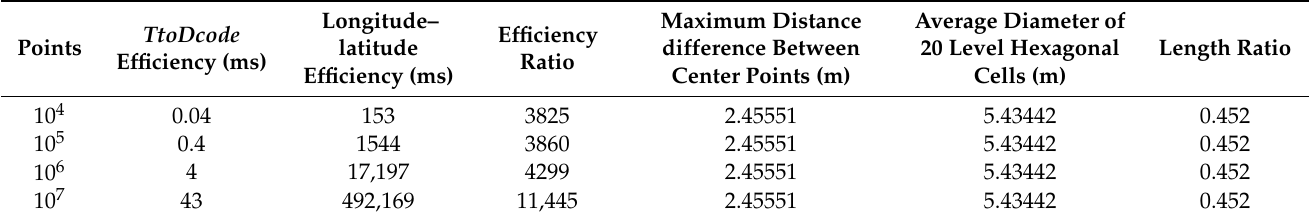
Table 17. Comparison of efficiency and accuracy of TtoDcode and longitude–latitude expressing discrete points.